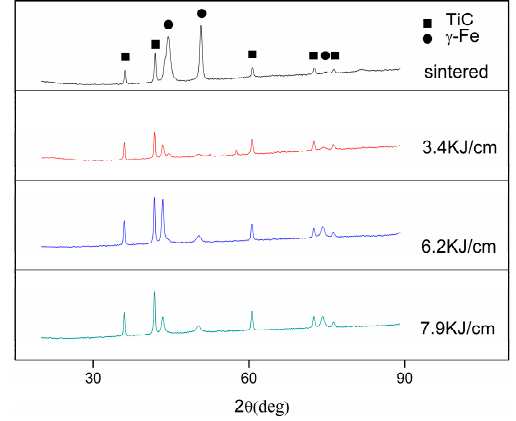
Figure 4. XRD patterns of TiC cermet.